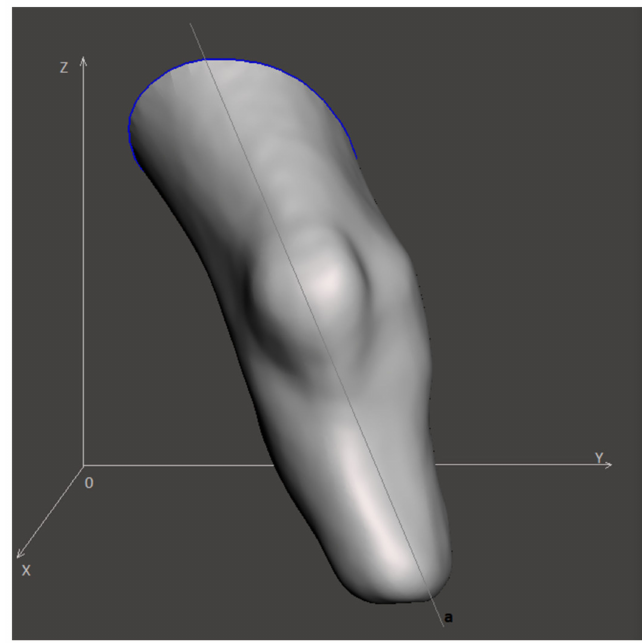
Figure 1. Visual representation of the input